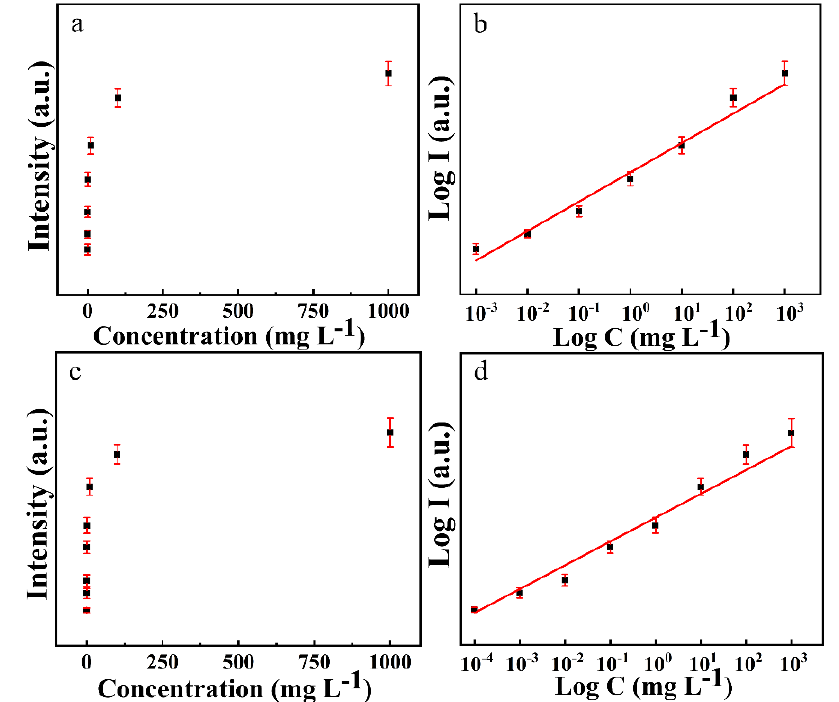
Figure 5. Linear relationship established for CPF and 2,4-D standard solution. Relationships of intensities of the SERS characteristic peak at 675 cm − 1 and concentrations of CPF shown in linear coordinates ( a ) and log coordinates ( b ). Relationships of intensities of the SERS characteristic peak at 392 cm − 1 and concentrations of 2,4-D shown in linear coordinates ( c ) and log coordinates ( d ).